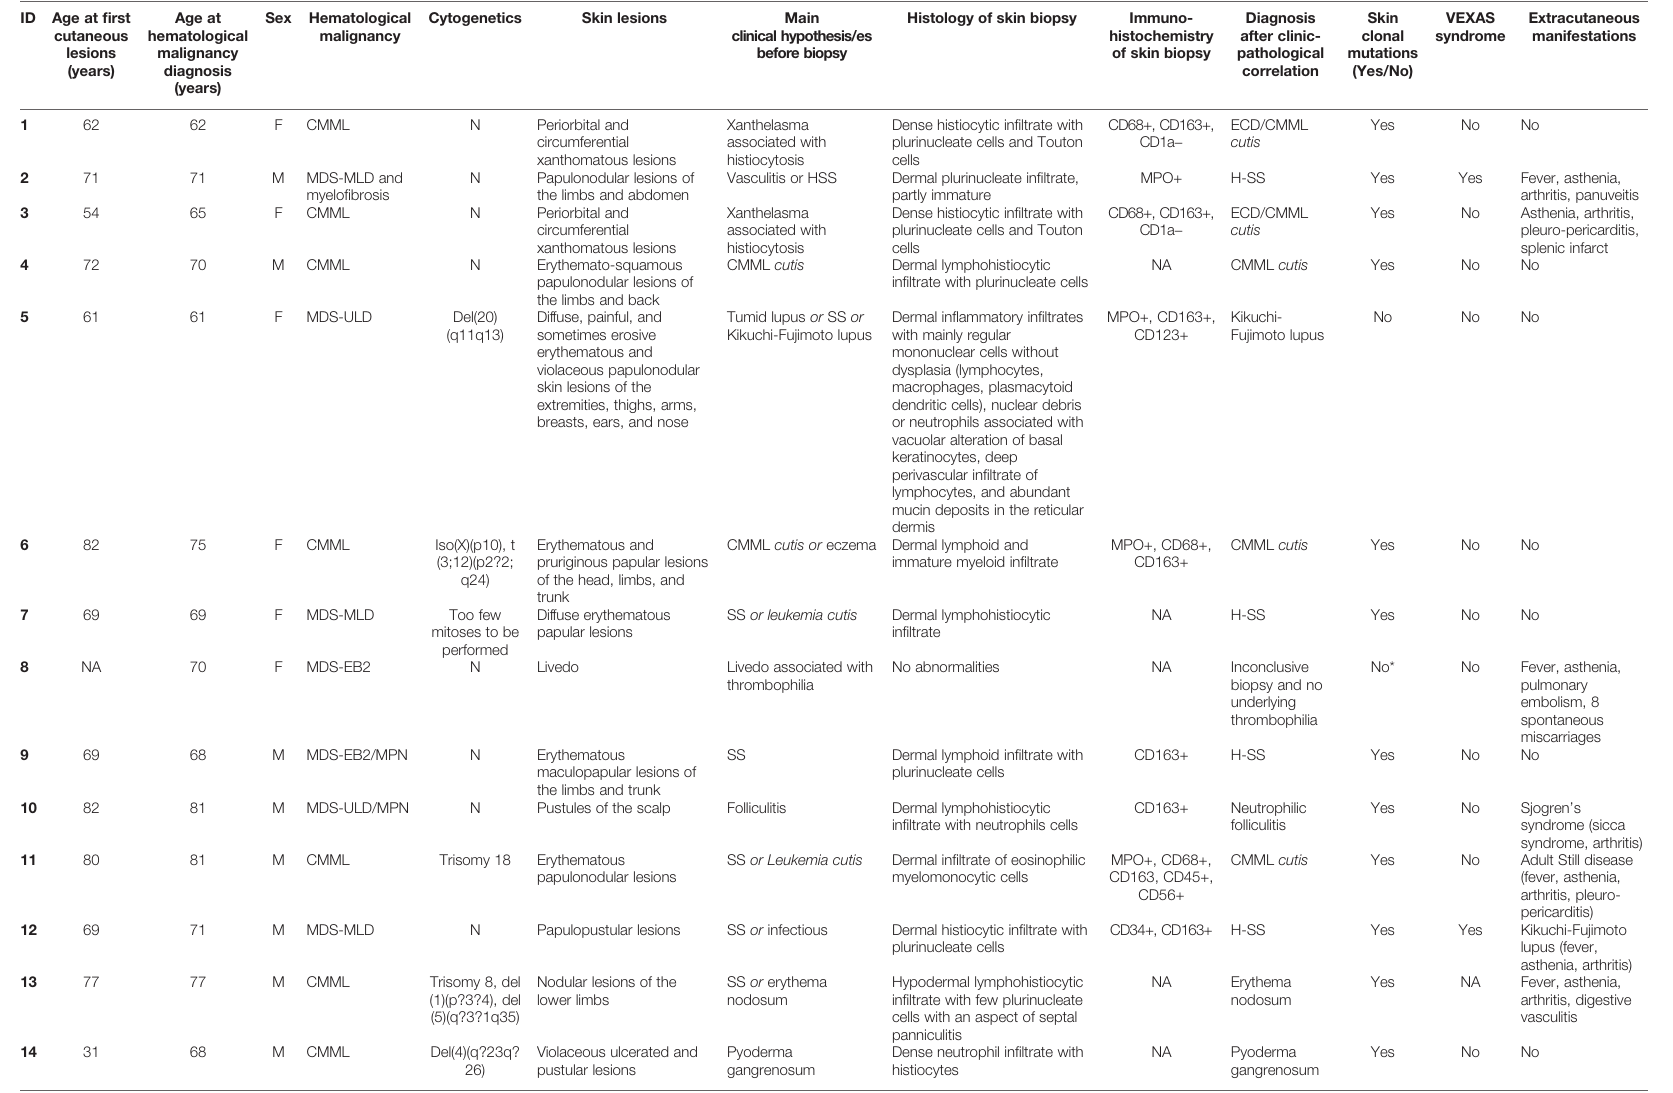
CMML,chronicmyelomonocyticleukemia;del,deletion;EB2,excessblastssubtype2;ECD,Erdheim-Chesterdisease;F,female;iso,isochromosome;M,male;MDS,myelodysplasticsyndromes;MLD,multilineagedysplasia;MPN,myeloproliferativeneoplasm; MPO,myeloperoxidase;N,normal;NA,notavailable;(H)-SS,(Histiocytoid-)Sweet ’ ssyndrome;t,translocation;ULD,unilineagedysplasia; ‑ ,biopsiedskinlesions;±,skinbiopsyanalyzedwithNGS;*,the3%skinVAFwith0%myeloidin fi ltratewasinterpretatedas a blood contamination facilitated by a highly circulating clone (blood VAF